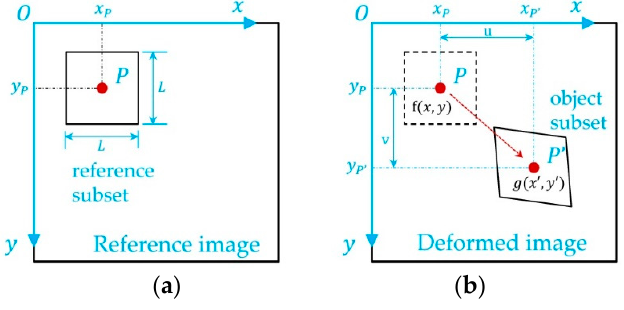
Figure 6. Schematic sketch of the two-dimensional digital speckle correlation method: ( a ) un-deformed image; and ( b ) deformed image. P is a reference point.